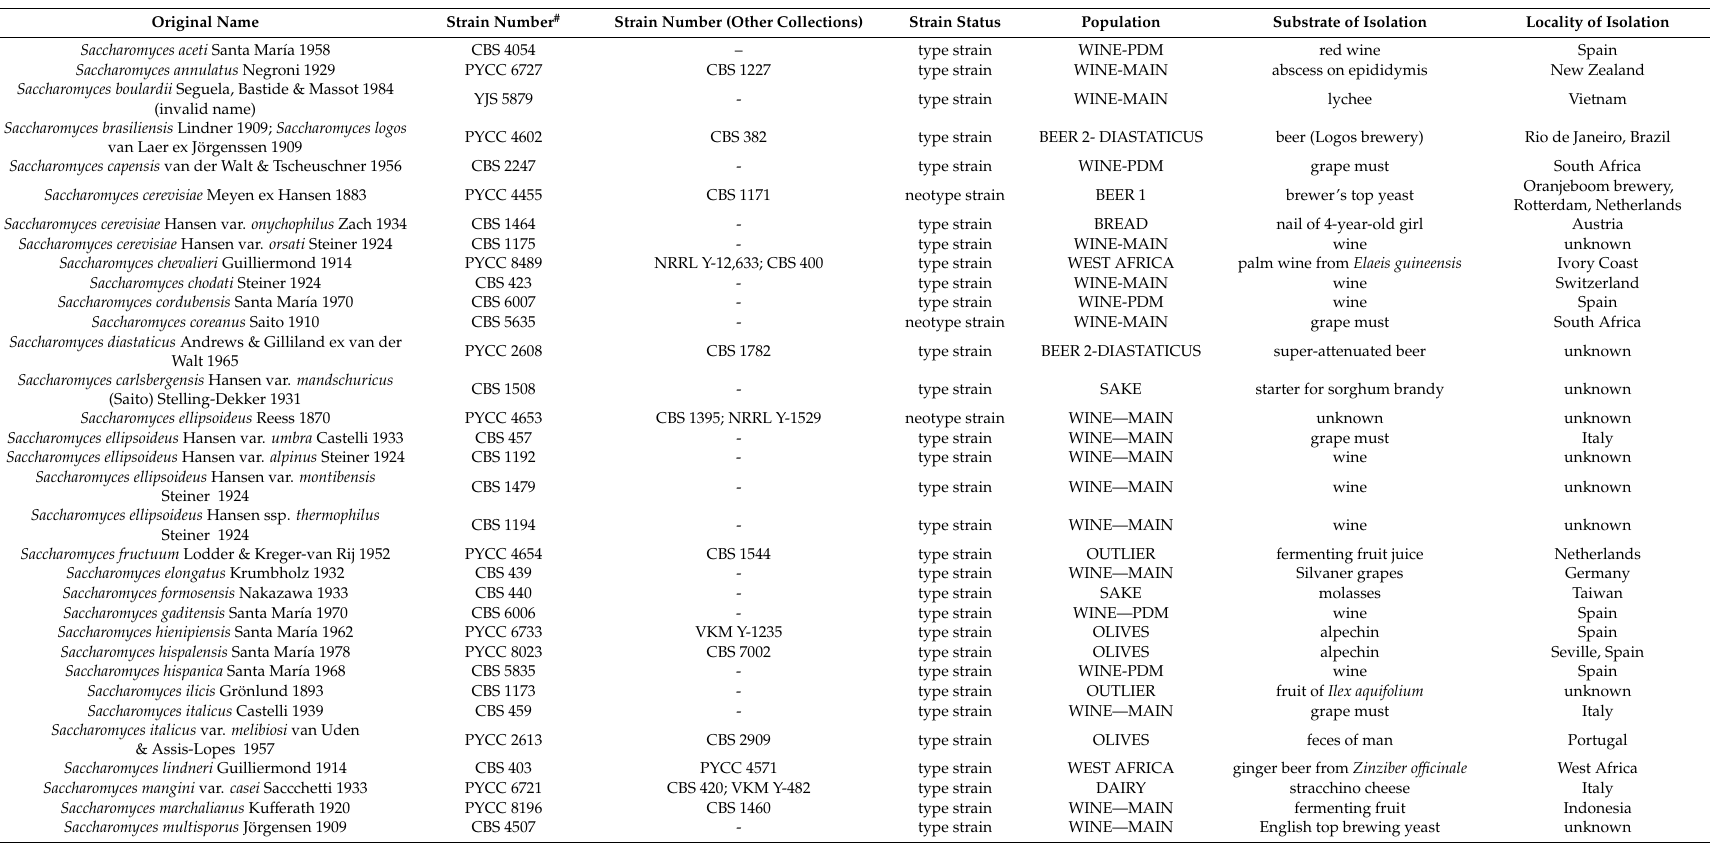
Table 1. Synonyms of Saccharomyces cerevisiae analyzed in this study and relevant information pertaining to them (the type strain of S. cerevisiae is also